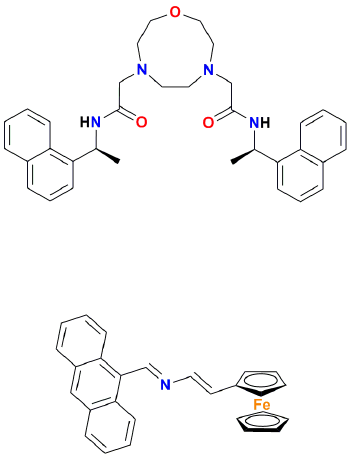
Scheme 12. Fluorescent Li + sensors 28 ( top ) and 29 ( bottom ).